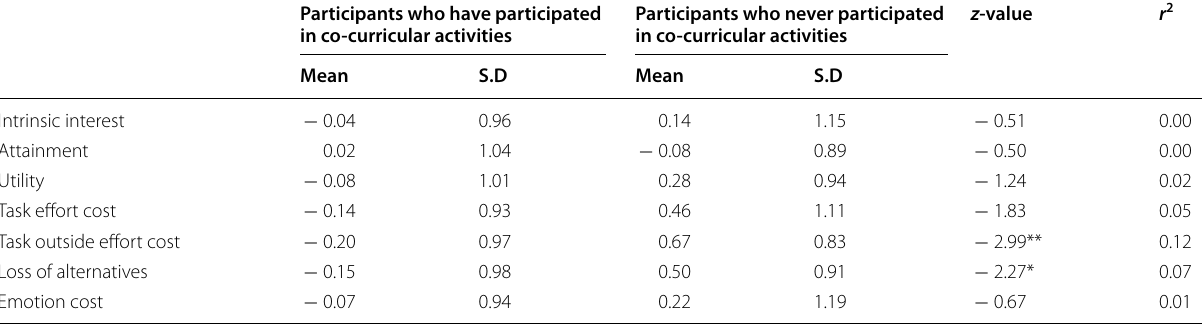
Table 3 Mann–Whitney U test: motivation Pattern by two co-curricular